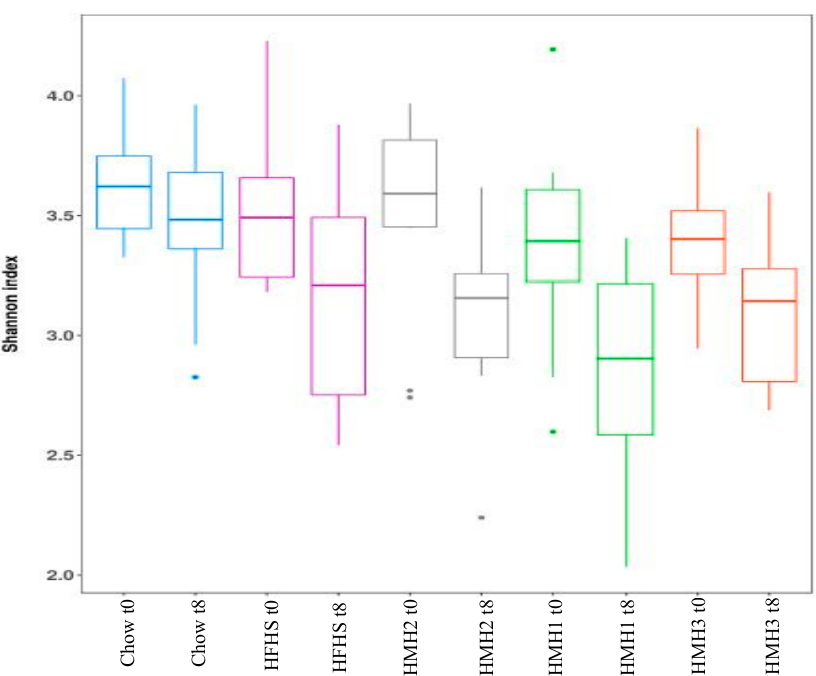
Figure 3. None of the treatments impacted the Alpha-diversity of gut microbiota before and after the different treatments, as measured with the Shannon index. ( n = 11 − 12).